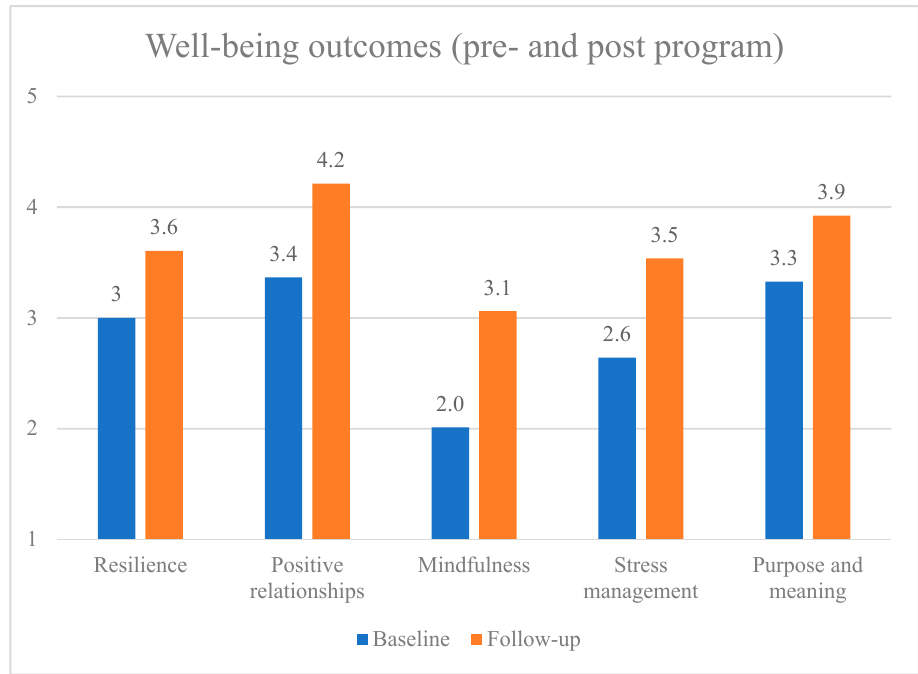
Figure 3. Evaluation of well-being areas (a higher number indicates a better score).